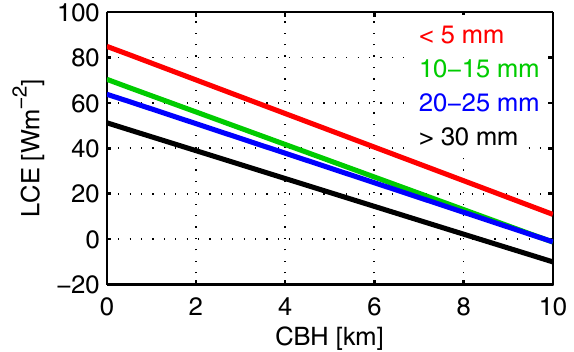
Figure 8. Distribution of SCE rel values for Davos for low-level clouds (Sc, Cu, St–As, Cb–Ns). The measured direct SW radiation is below (red) or above (blue) a threshold of 120Wm − 2